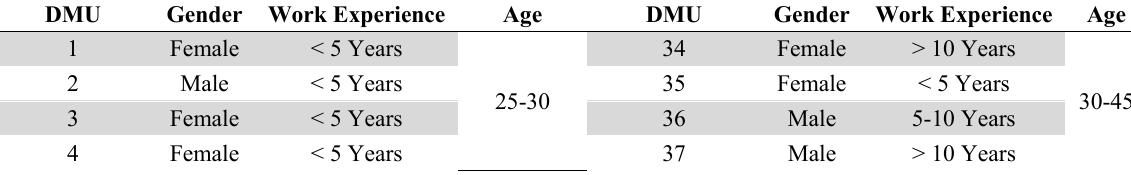
Table C2 The demographic features of retailers’ participants DMU